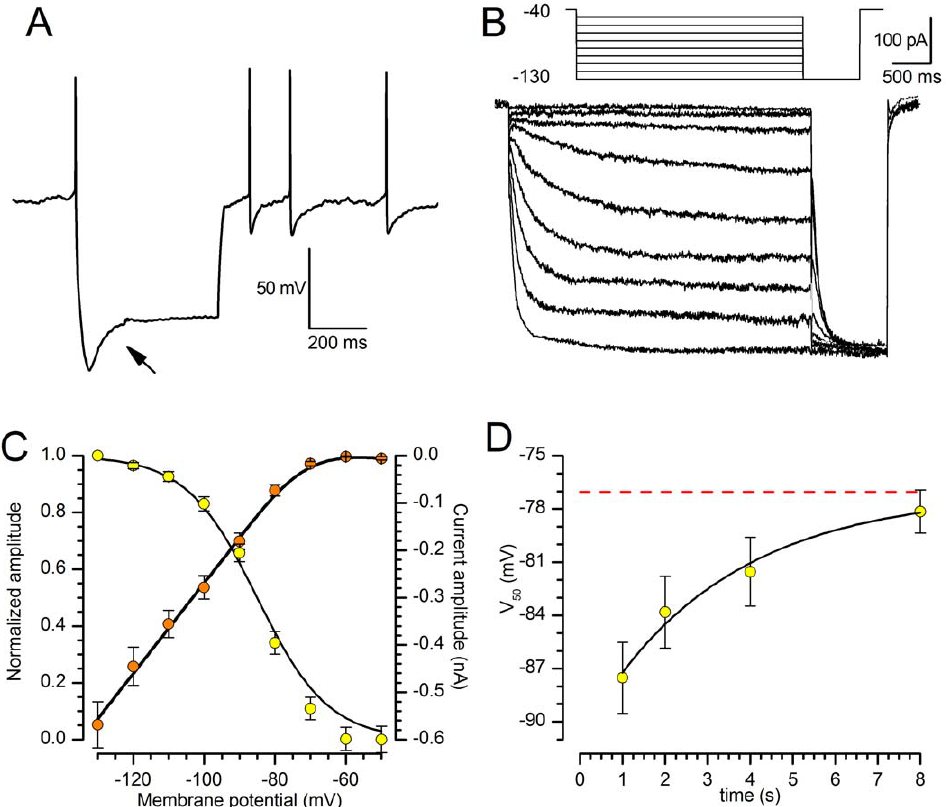
Figure 1. Basic properties of the h-current at 37 6 C. A: Response of a SNc DA neuron under current-clamp condition to the injection of a 300 pA hyperpolarizing current pulse. Note the appearance of the archetypal sag (arrow) due to the activation of I h ; resting potential 2 55 mV, bath solution for this recording was standard ACSF. B: Family of responses of a SN DA neuron under voltage-clamp conditions to the application of the double- pulse protocol shown in the inset above; explanation in the text. C: Current-voltage relationship of the h-current ( % , right y-axis) and voltage- dependence of the activation curve ( # , left y-axis) obtained from tail analysis of double-pulse experiments as shown in panel B; mean value 6 S.E. (n=20). D: Dependence of the midpoint (V 50 ) on the duration of the hyperpolarizing pulse; the dashed line highlights the asymptotical behavior of the midpoint for a conditioning pulse of infinite duration - see text for explanation.